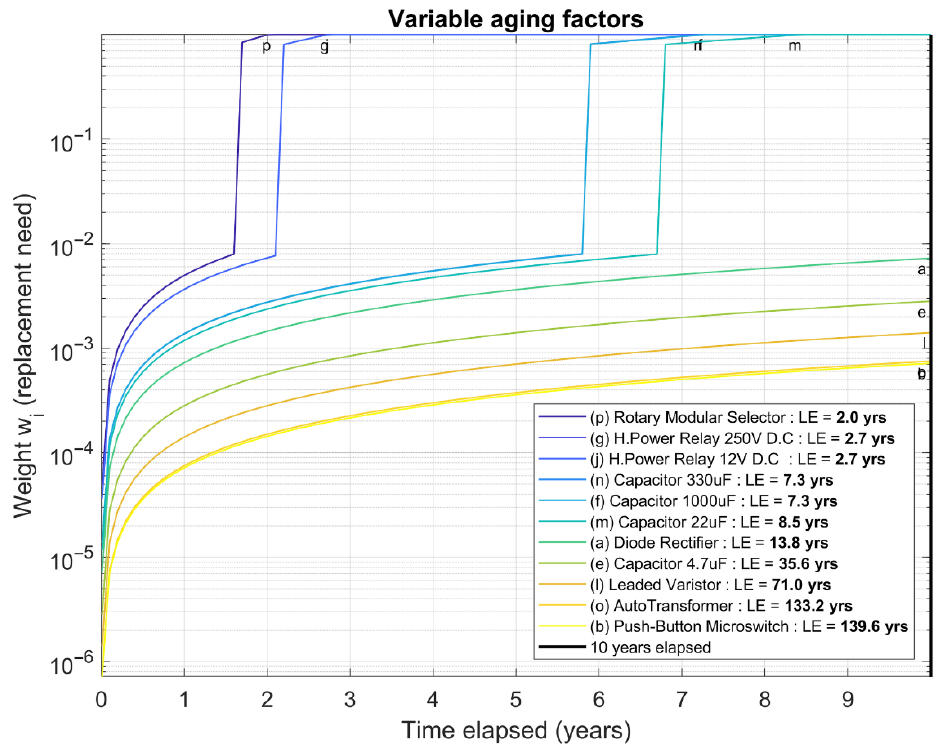
Figure 5. Weight of components to be replaced versus time elapsed for a washing machine’s PCB.